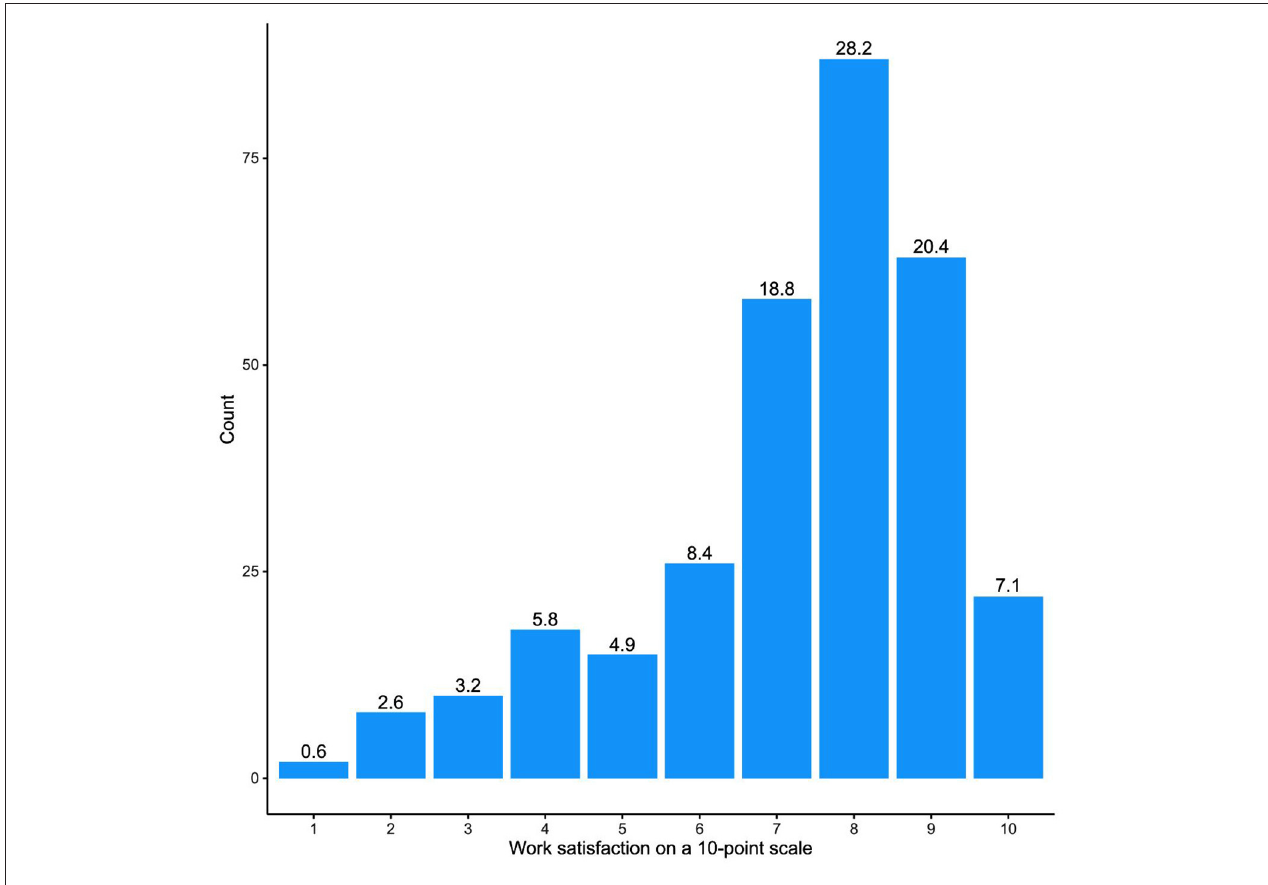
FIGURE 4 | Job satisfaction of pediatricians in the survey ( N =